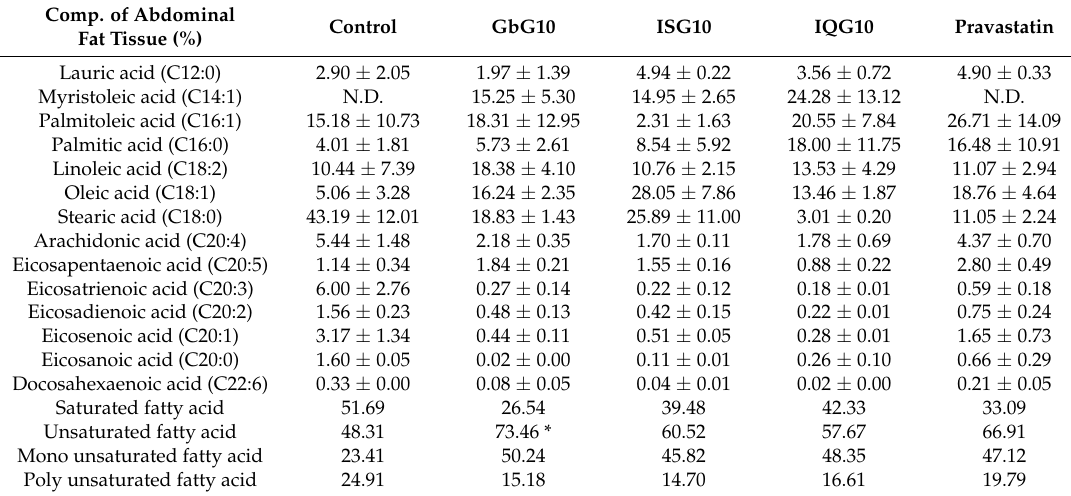
Each value represents mean ± SD. Asterisk marks (*) mean significant differences compared with the control (PBS) group ( p < 0.05). N.D.: not detected.